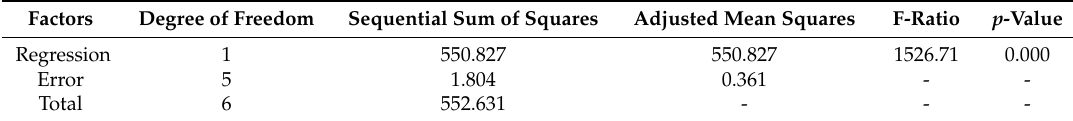
Table 7. Analysis of variance for the machining